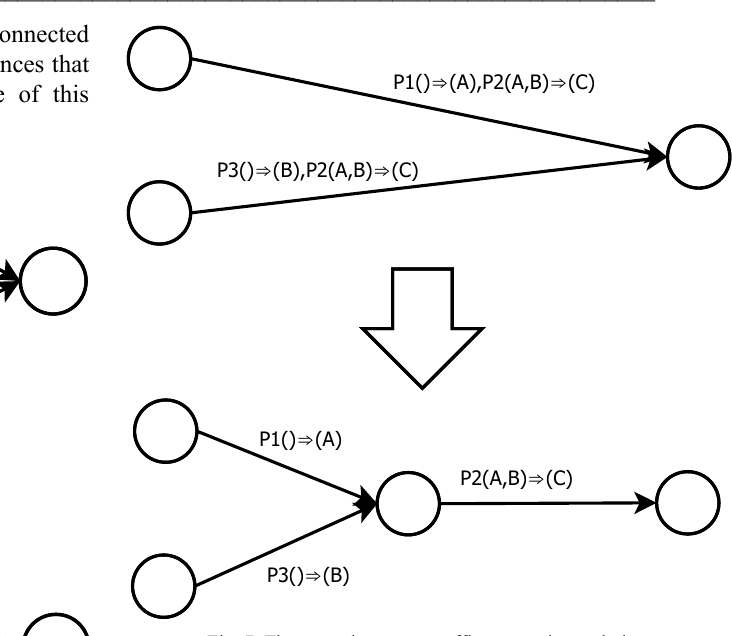
Fig. 7. The second common suffix processing